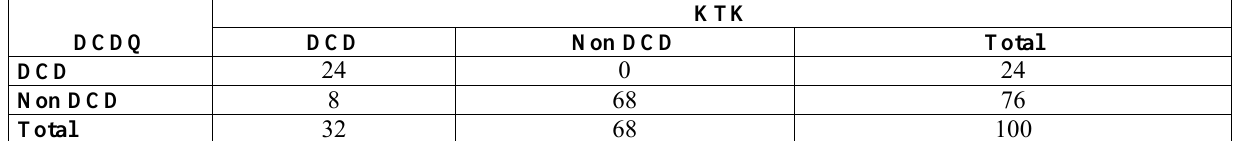
Classification of DCD with the KTK compared to the